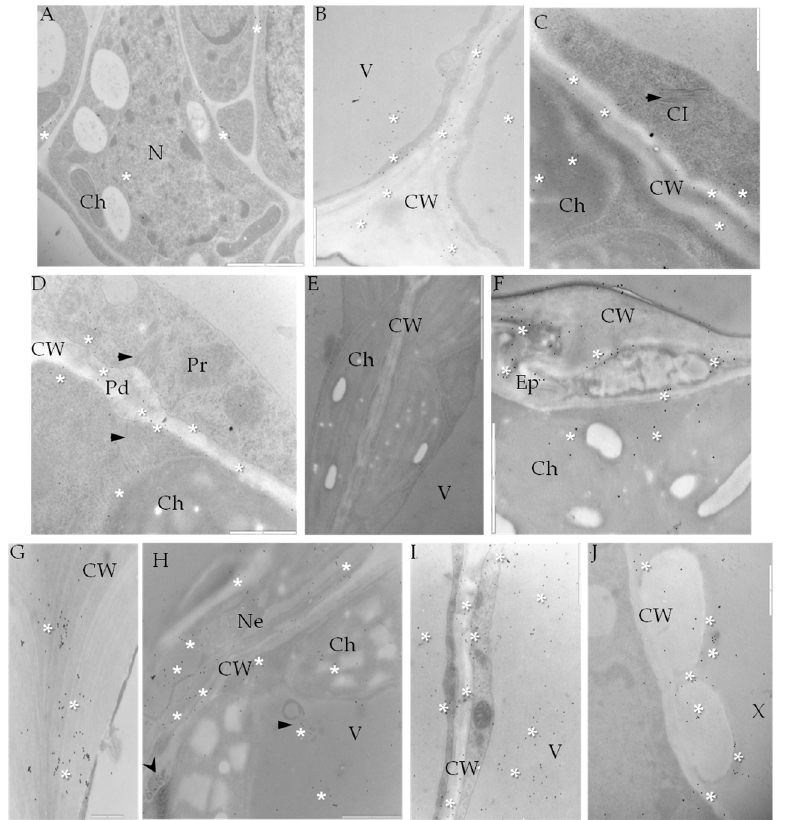
Figure 10. Immunogold labeling of extensin (HRGP) in potato–PVY NTN compatible ( B – D ) and